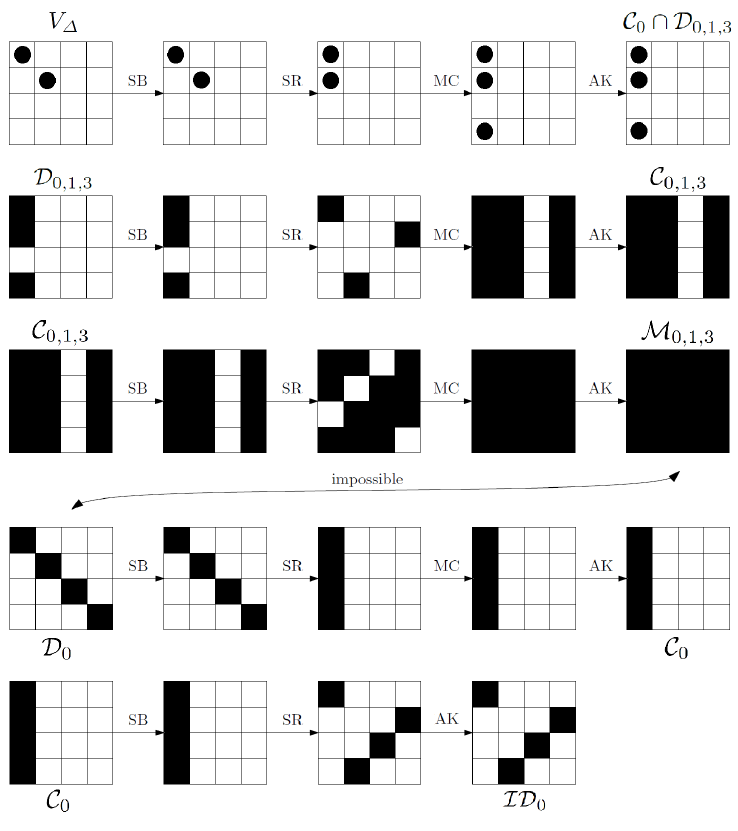
Figure 10: 5-Round Secret Key Distinguisher for AES with a single secret S-Box with data complexity 2 98 . 2 based on the Impossible Subspace Trail on 4-Round (from Sect. 4.4).